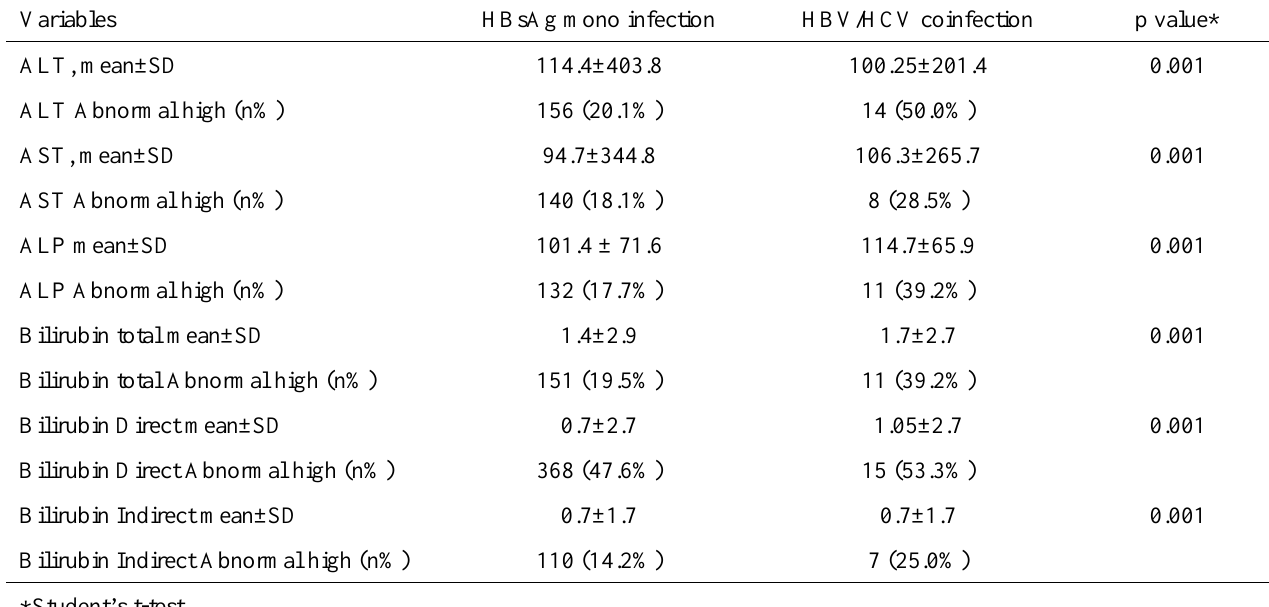
Table 2. Liver function profile in HBV mono-infected patients and those with HBV/HCV co-infected patients. reported in HBV/HCV co-infected patients compared to those having HBV and HCV mono-infection 26 .